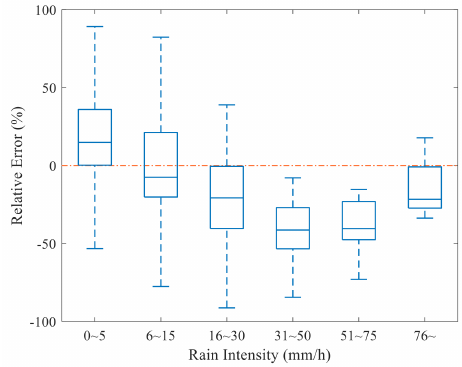
Figure 8. The statistical relative errors between OEL and OTT for di ff erent rain intensity